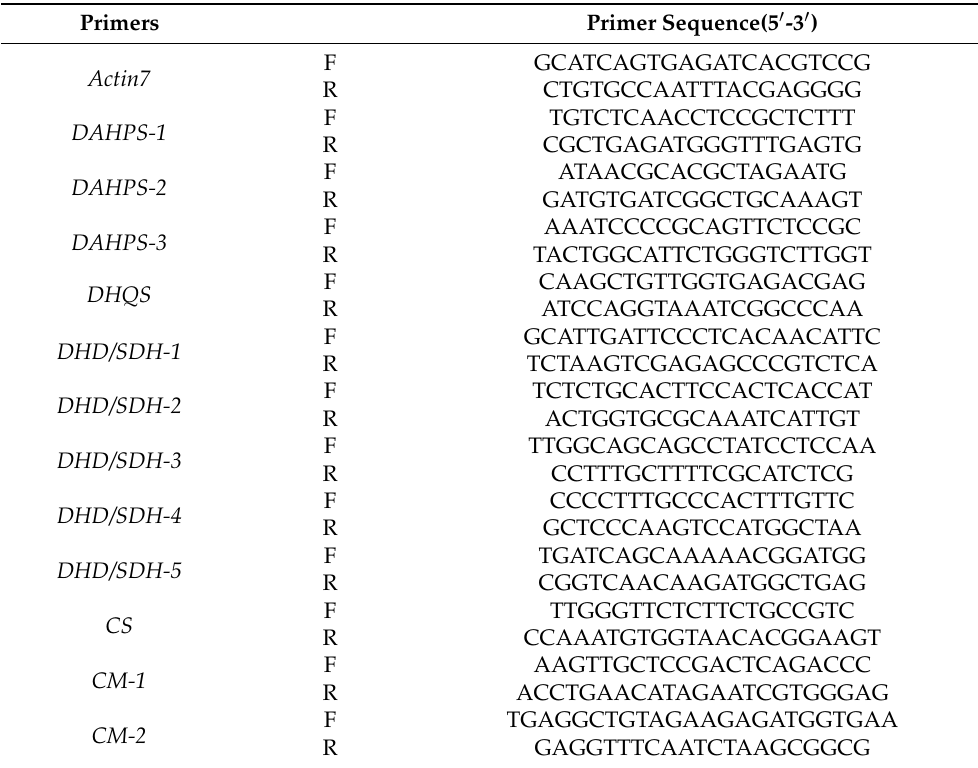
Table A2. Primer sequences for RT-qPCR.